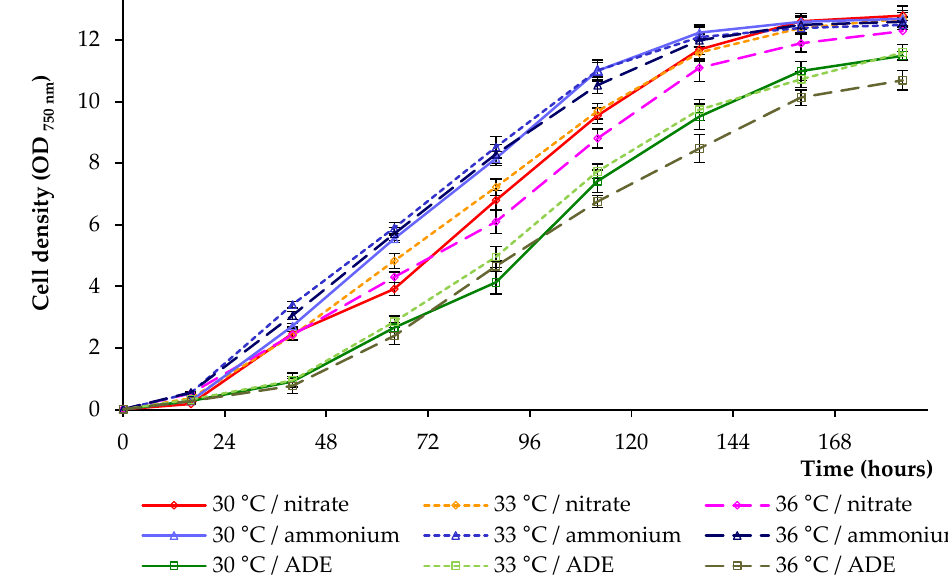
Figure 1. Growth of C. sorokiniana AM-02 cultured under different conditions. Table 1. C. sorokiniana culture characteristics when grown under different conditions.